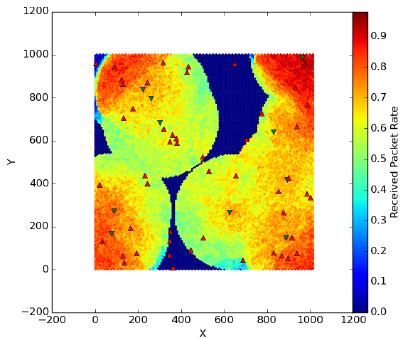
Figure 10. RPR with 50 noise nodes at h